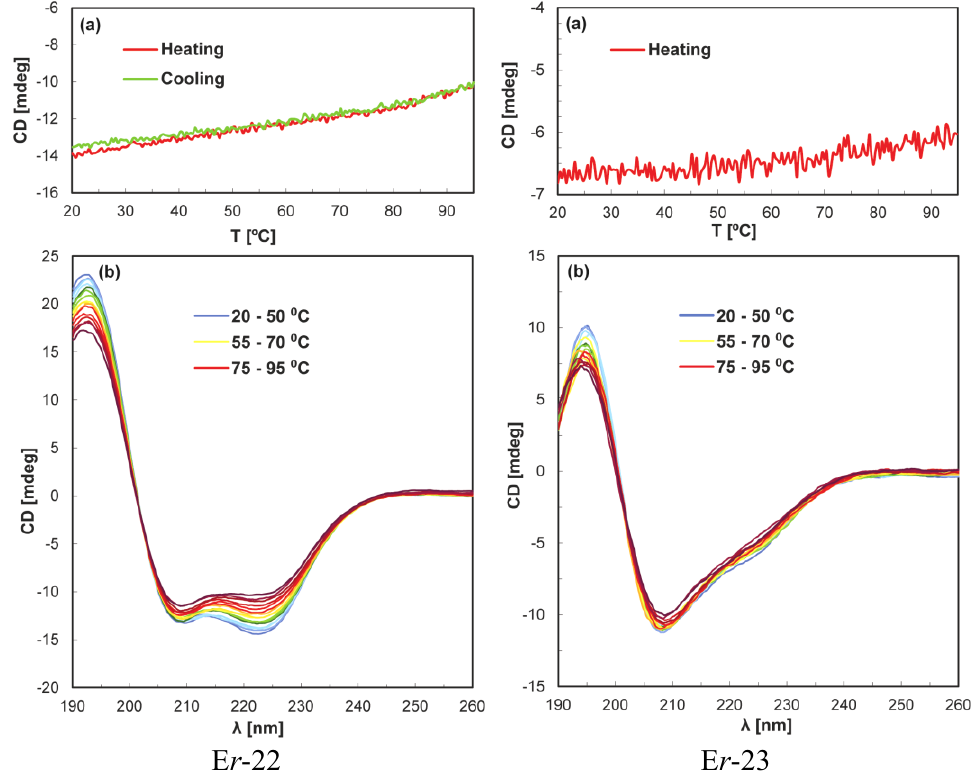
Figure 3. Temperature-induced denaturation of the E. raikovi mesophilic pheromones E r -22 and E r -23 monitored by CD spectroscopy. E r -22 has been taken as representative of the other E. raikovi pheromones E r -1, E r -2, E r -10 and E r -11. Same experimental conditions and presentations as in Figure 2, except that all the spectra recorded in 5 °C temperature intervals are shown in panels ( b